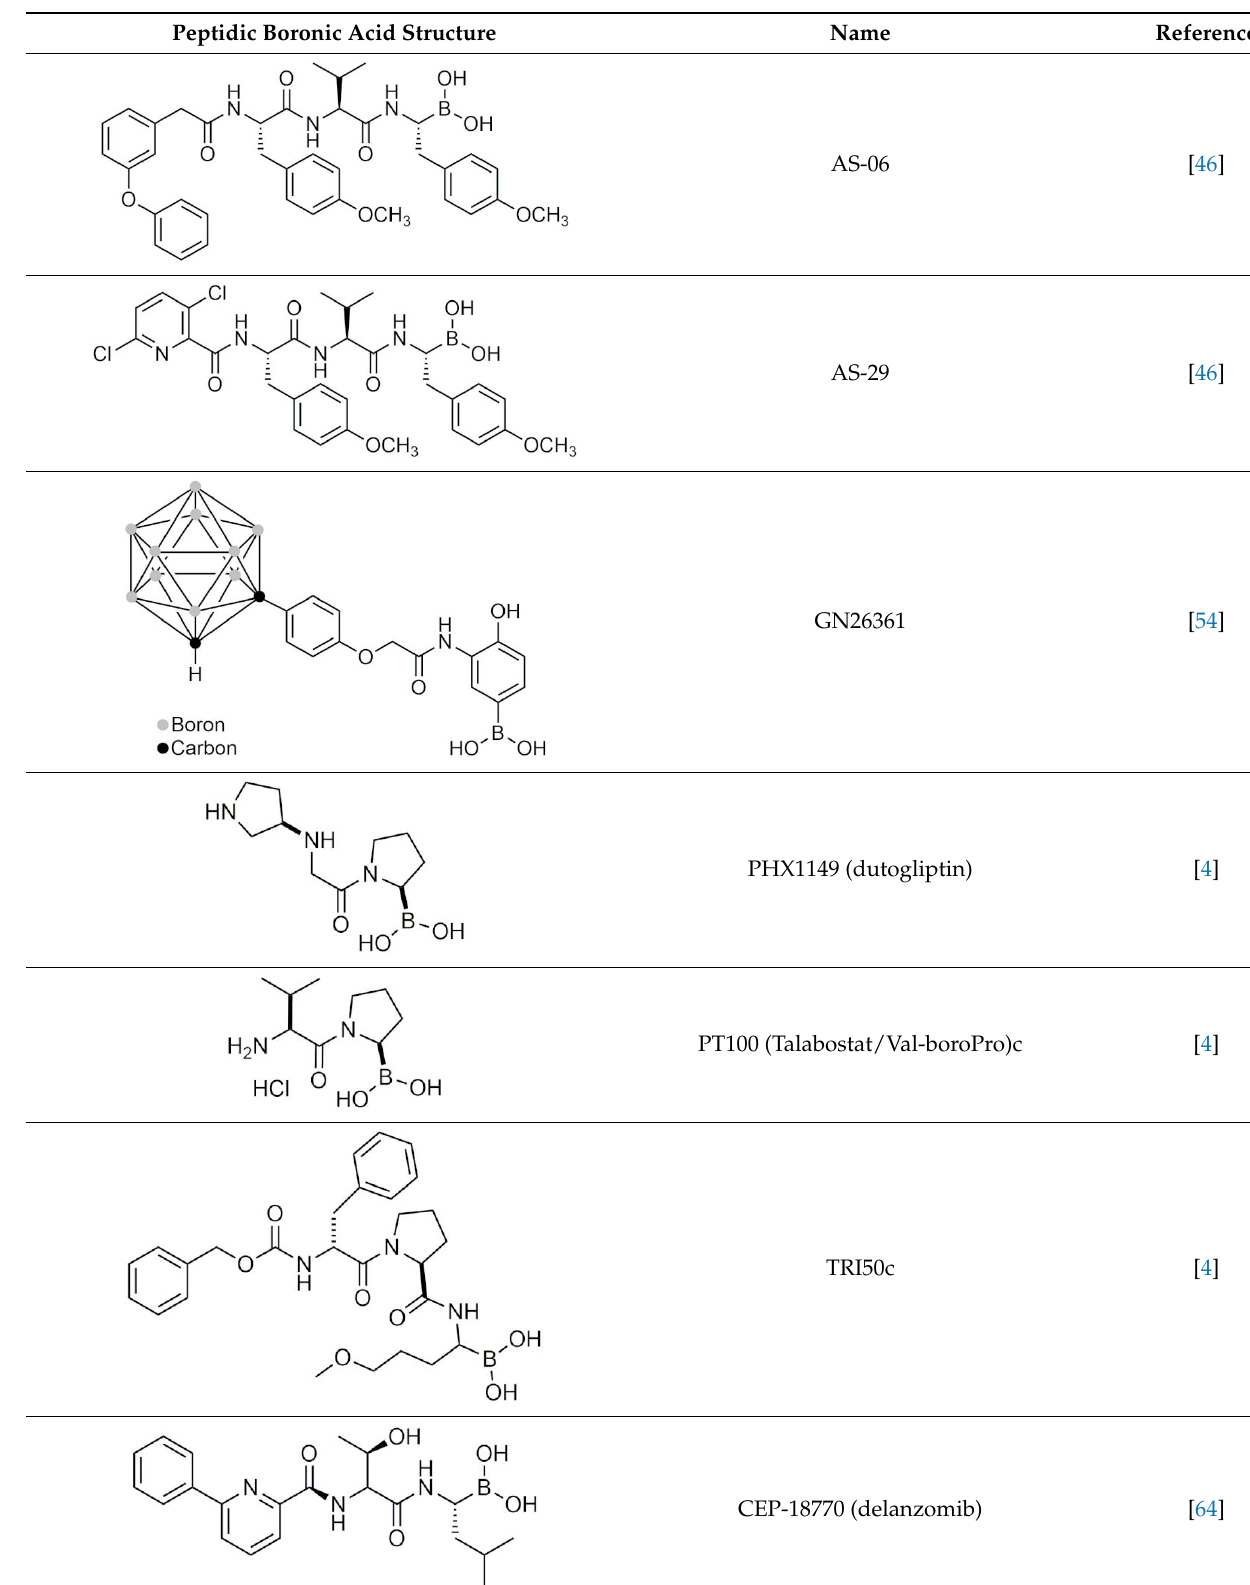
Table 2. Peptidic boronic acid medicinal